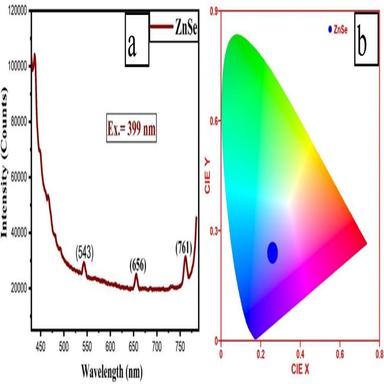
(a) Photoluminescence emission spectra of ZnSe NRs (b) Photoluminescence CIE diagram of ZnSe NRs.